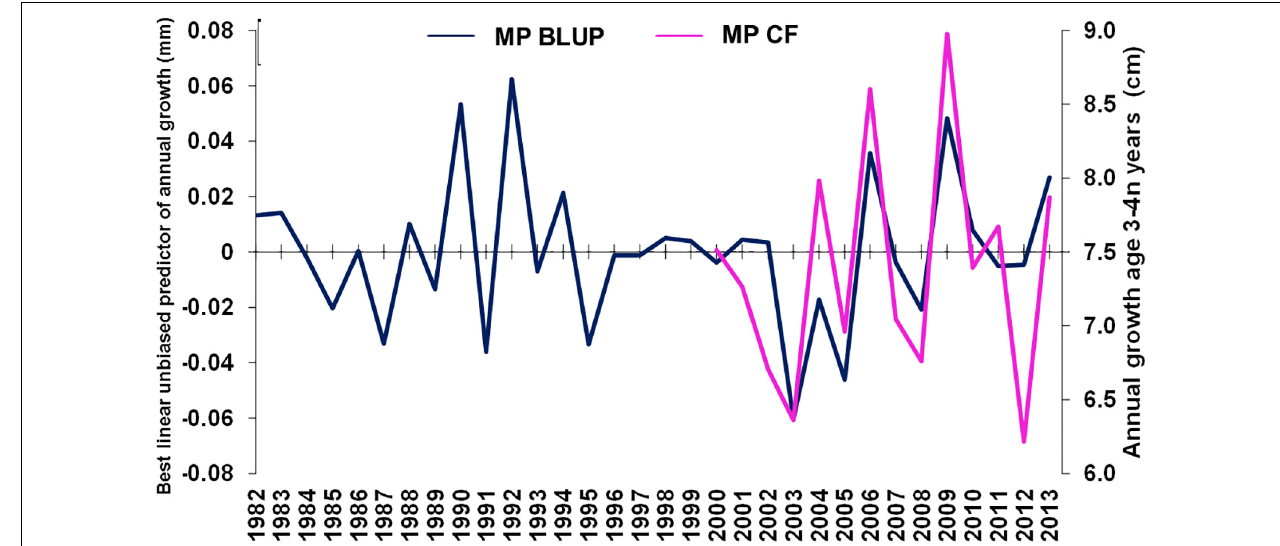
FIGURE 5 | Merluccius paradoxus (MP) caught in Namibia best linear unbiased predictor (BLUP) of annual growth from otolith increments (blue) and age 3 annual growth calculated from annual age-length keys (pink) against year.